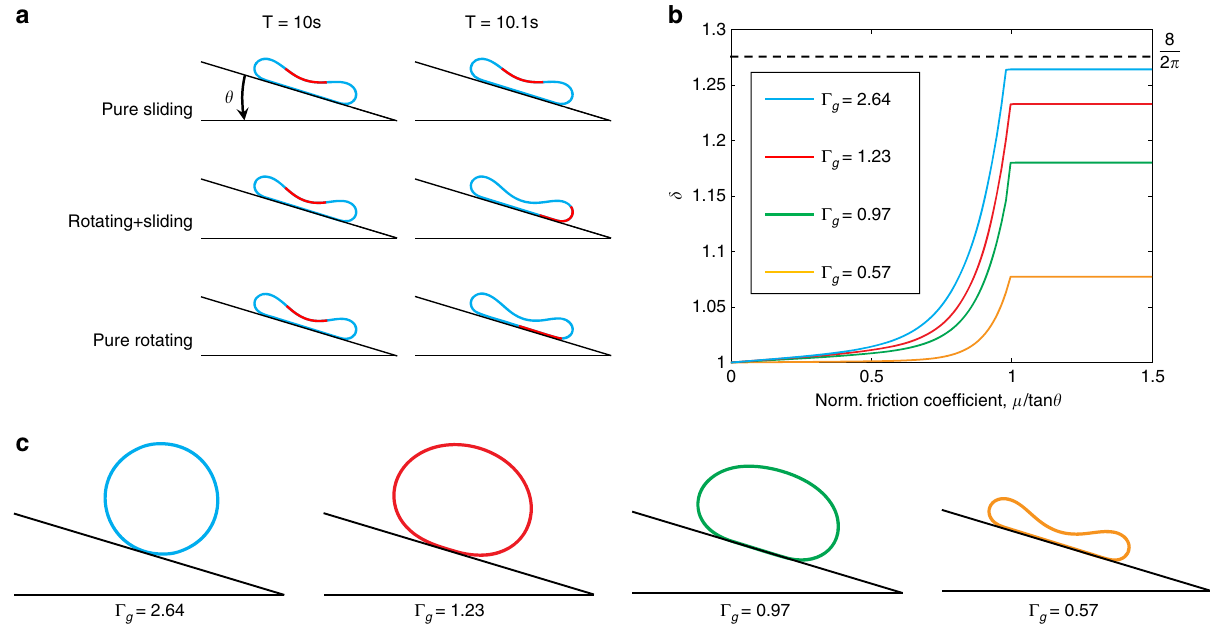
Fig. 2 Motion patterns of elastic ribbons. a Three different patterns in rolling ribbons: pure sliding ( μ /tan θ = 0), combination of sliding and rotating (0 < μ /tan θ < 1); and pure rotating ( μ /tan θ ≥ 1). b The ratio between the route of ribbon boundary point and ribbon centroid, δ = s normalized frictional coef fi cient μ /tan θ , for different values of normalized ribbon curvature, Γ g . c Different typologies of rolling ribbons with different Γ g